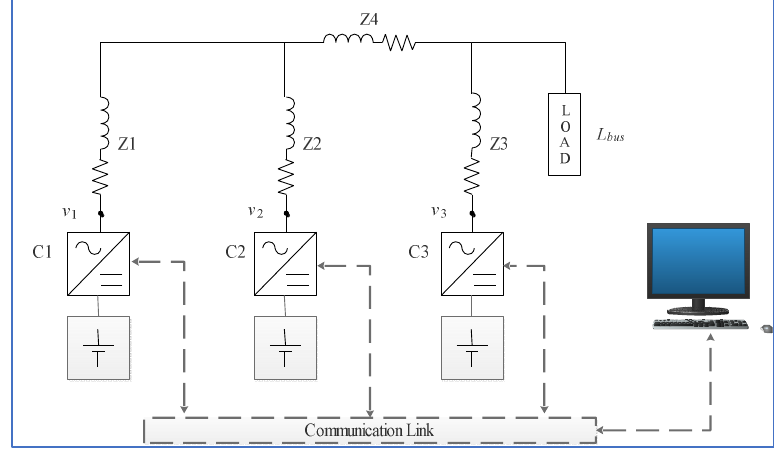
Figure 1. Diagram of the microgrid under study. Table 1. Hardware parameters.